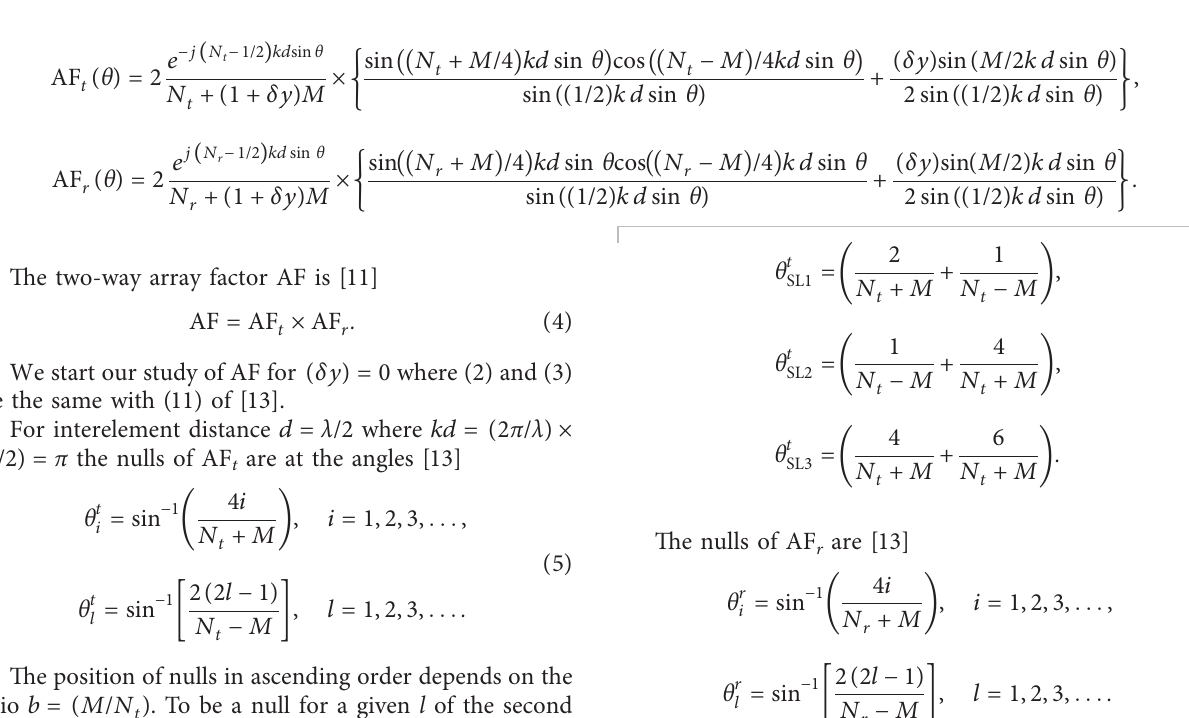
Figure 1: Radar transmit and receive linear